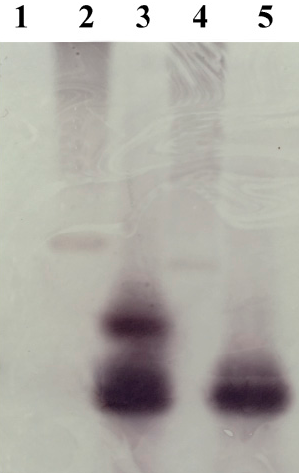
Figure 3. Southern blot analysis of Ar-far-1 in Aphelenchoides ritzemabosi. Lane 1: gDNA from carrot callus digested with restriction enzyme EcoR I; Lane 2: Plasmid pET-32a- Ar-far-1 digested with restriction enzyme Dra I inside Ar-far-1 gene; Lane 3: gDNA from A. ritzemabosi digested with restriction